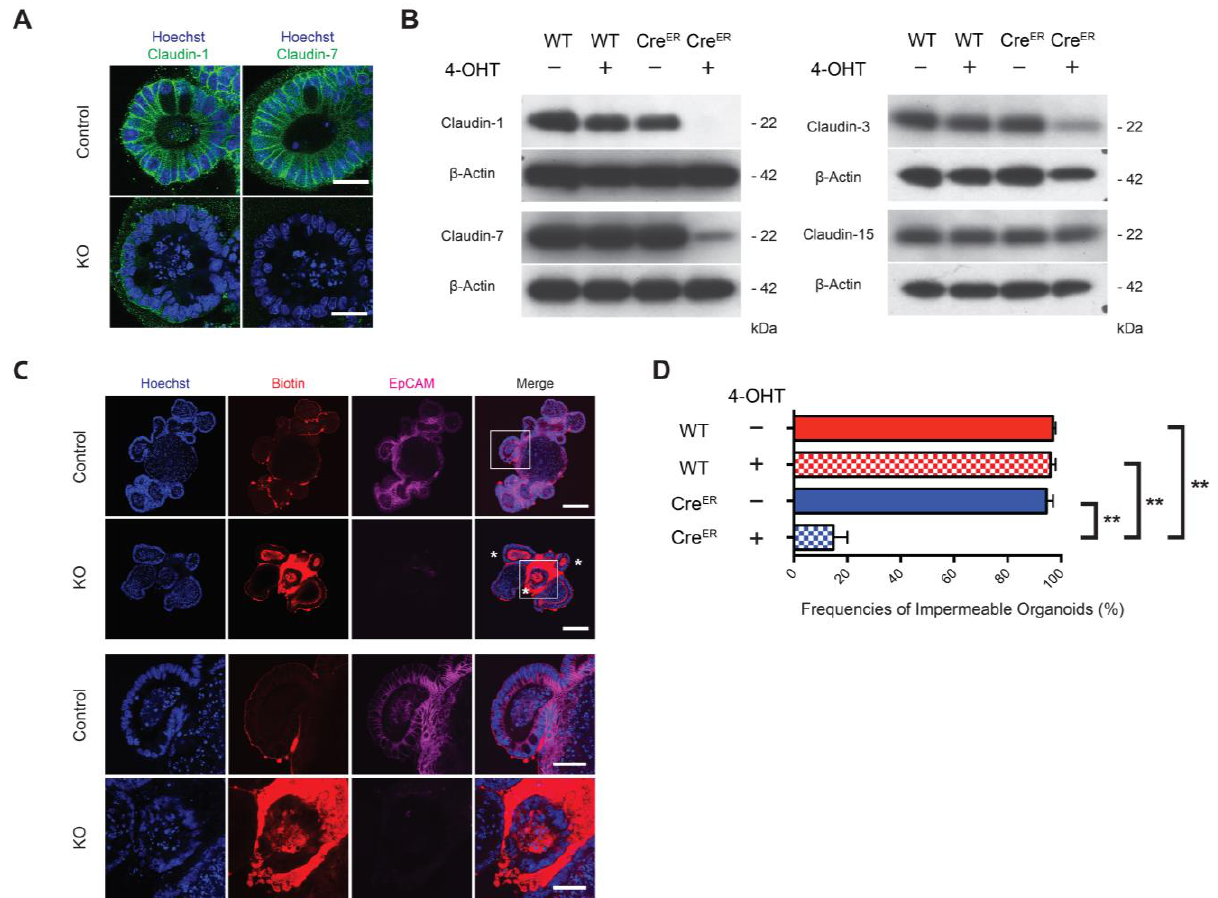
Figure 3. Reduced claudins and compromised epithelial integrity in EpCAM-deficient organoids. ( A ) Reductions in claudin-1 (left) and claudin-7 (right) expression in KO organoids. claudin staining (green). Bars = 25 µ M. ( B ) Reduction of claudins in KO organoids by Western blotting. WT represents EpCAM fl/fl and Cre ER represents ROSA26-Cre ERT2+ EpCAM fl/fl orgnoids. Results from 1 of 3 independent experiments. ( C ) Organoid permeability (epithelial integrity) was assessed via fluorescence microscopy after sulfo-NHS-LC-biotin (red) treatment. Bars = 100 µ M. Expanded views (lower panels) reveal labeling of KO organoids. Bars = 25 µ M. ( D ) Quantitation of organoid permeability. In each experiment in each condition, 50 organoids were randomly selected and frequencies of organoids with labeled luminal contents were determined. Data depicted represent aggregate data from three independent experiments (mean ± SEM; ** p < 0.01 via Student’s t test). Nuclear counterstaining, Hoechst 33342 (blue) in ( A , C ).